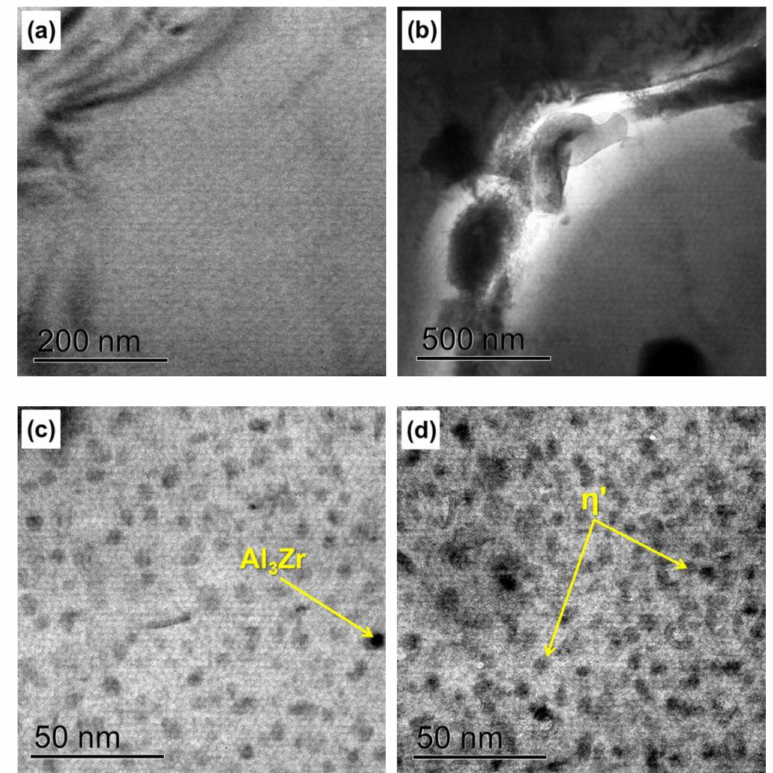
Figure 6. Transmission electron microscope (TEM) images of weldment: ( a ) within the grain in the fusion zone (FZ), ( b ) grain boundary in the FZ, ( c ) near heat-a ff ected zone (HAZ), and ( d ) far-HAZ.